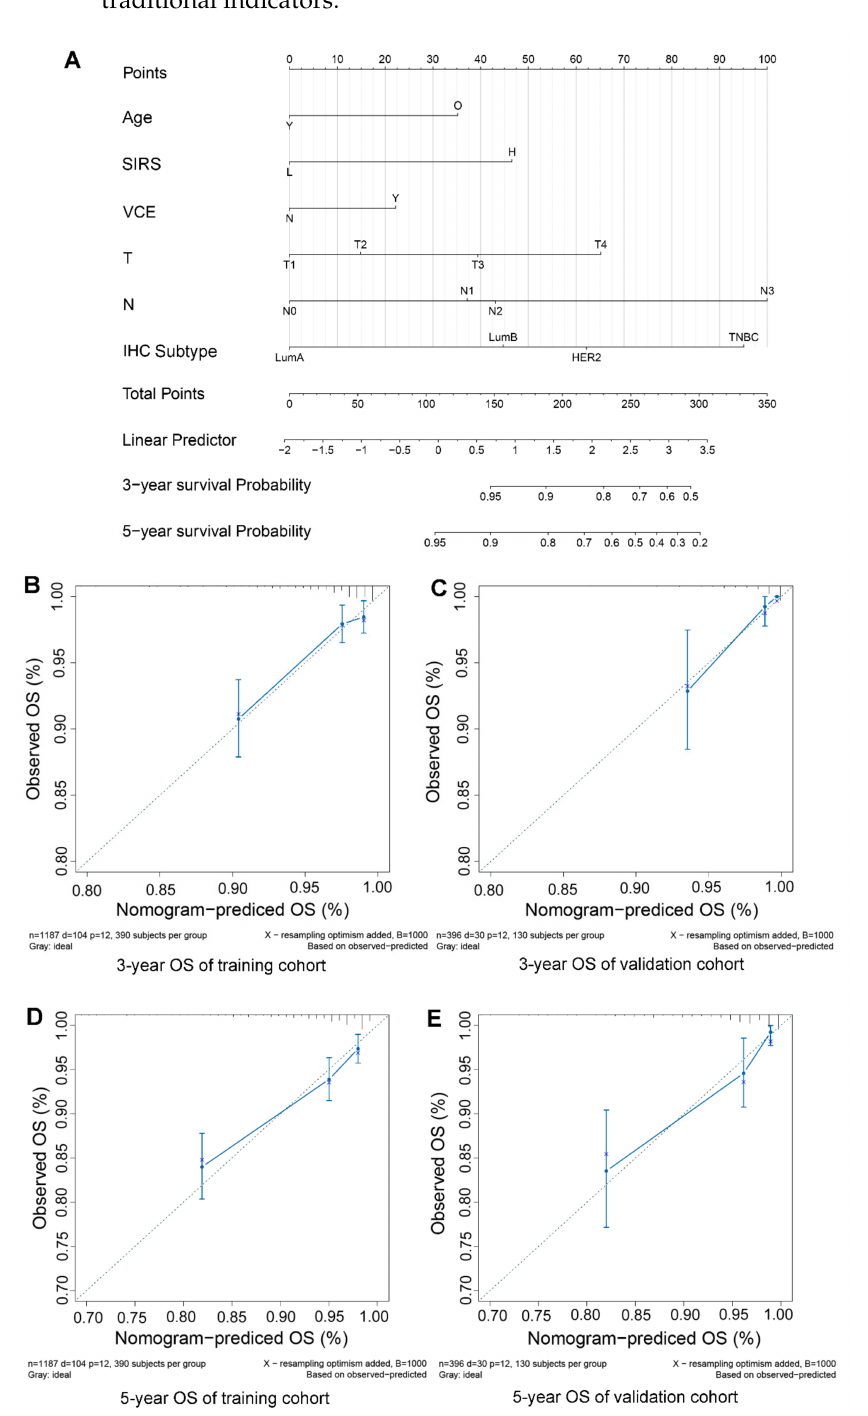
Figure 3. Nomogram predicting the overall survival for patients with breast cancer. ( A ). Nomogram for predicting OS of breast cancer patients after surgery. ( B , C ). Calibration plot of the nomogram for 3-year survival in the training cohort and external validation cohort. ( D , E ). Calibration plot of the nomogram for 5-year survival in the training cohort and external validation cohort. Abbreviation: vascular cancer emboli